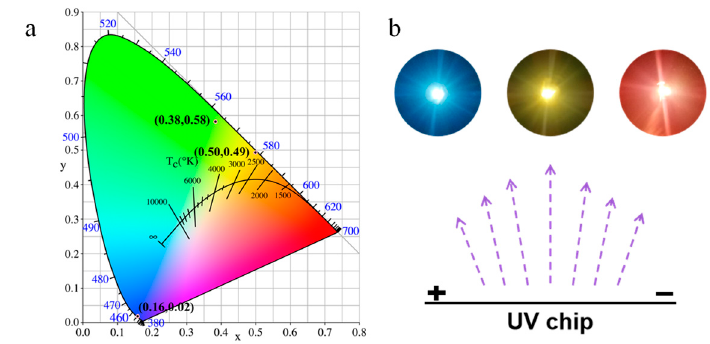
Figure 8. ( a ) The CIE color coordinates of the CDs/PVA based LEDs. ( b ) Optical photographs of the multicolor LEDs.